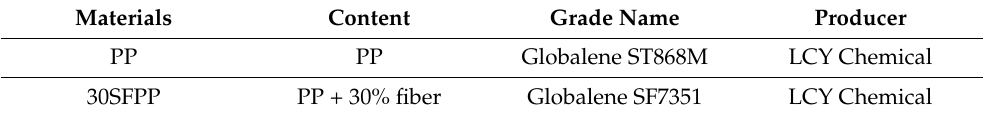
Table 1. Materials utilized in this study.